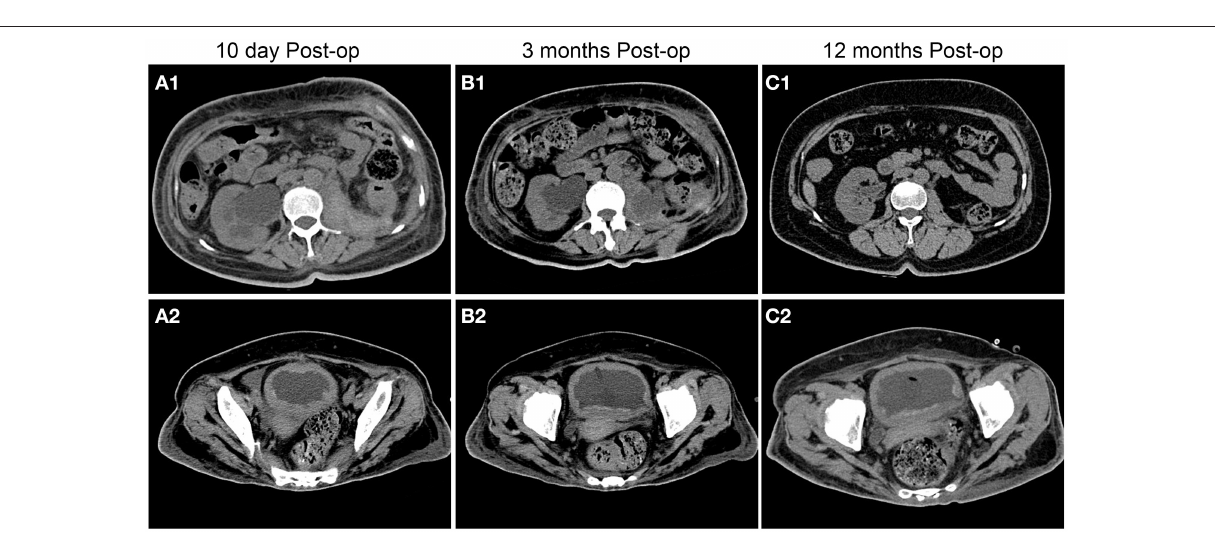
body, with the urinary system being the most common.